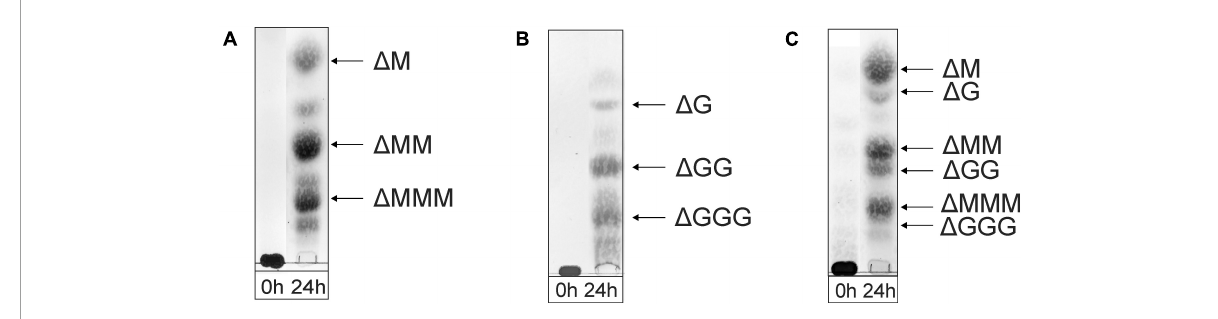
FIGURE3 TLC analysis of the oligosaccharide mixtures generated after a 24-h incubation of (A) M-block alginate, (B) G-block alginate, and (C) low-viscosity M. pyrifera alginate with the AlyRm3 enzyme. Positions of isolated and identified products with non-reducing terminal 4-deoxy- α - L - erythro -hex-4-enopyranosyluronic acid ( (cid:49) ) units are included (NMR analysis). Non-assigned bands are expected to stem from saturated oligosaccharides (MALDI-TOF-MS analysis). As the samples were run with several other samples, the 0-h control lanes and the